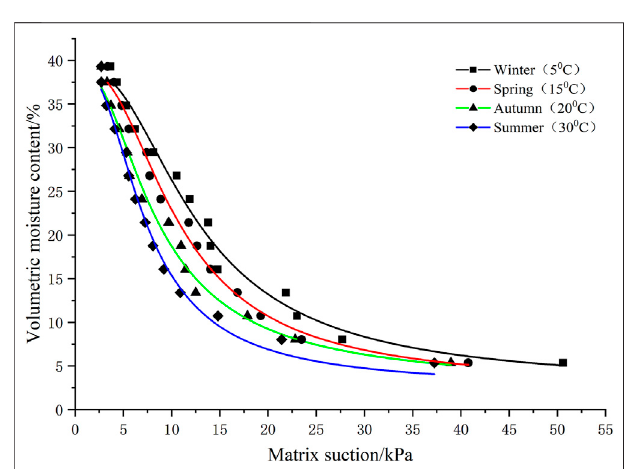
FIGURE 7 | The experimental data and best- fi t SWCC of tailings at different temperatures.